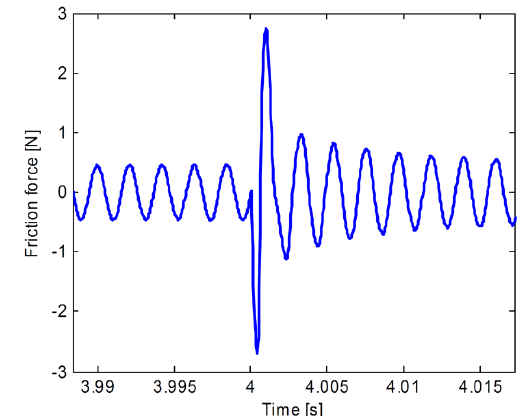
Figure 15. Friction predicted using Dahl